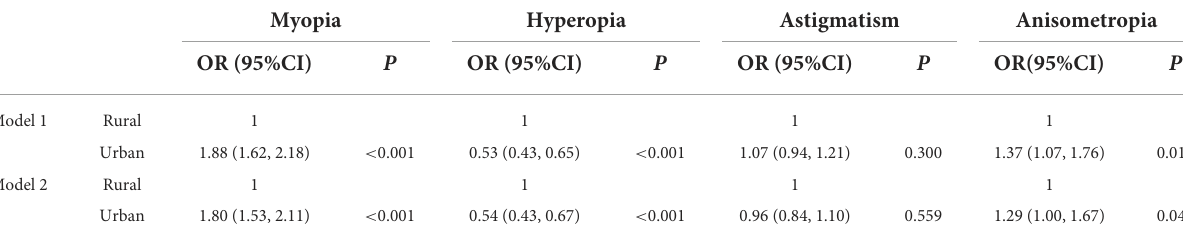
TABLE 4 Multivariate regression results for the differences on the risk for REs by region of habitation.